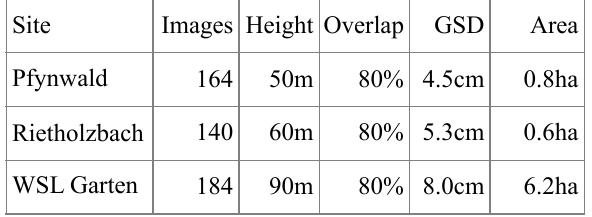
Table 1: Flight plans (ha = 10'000